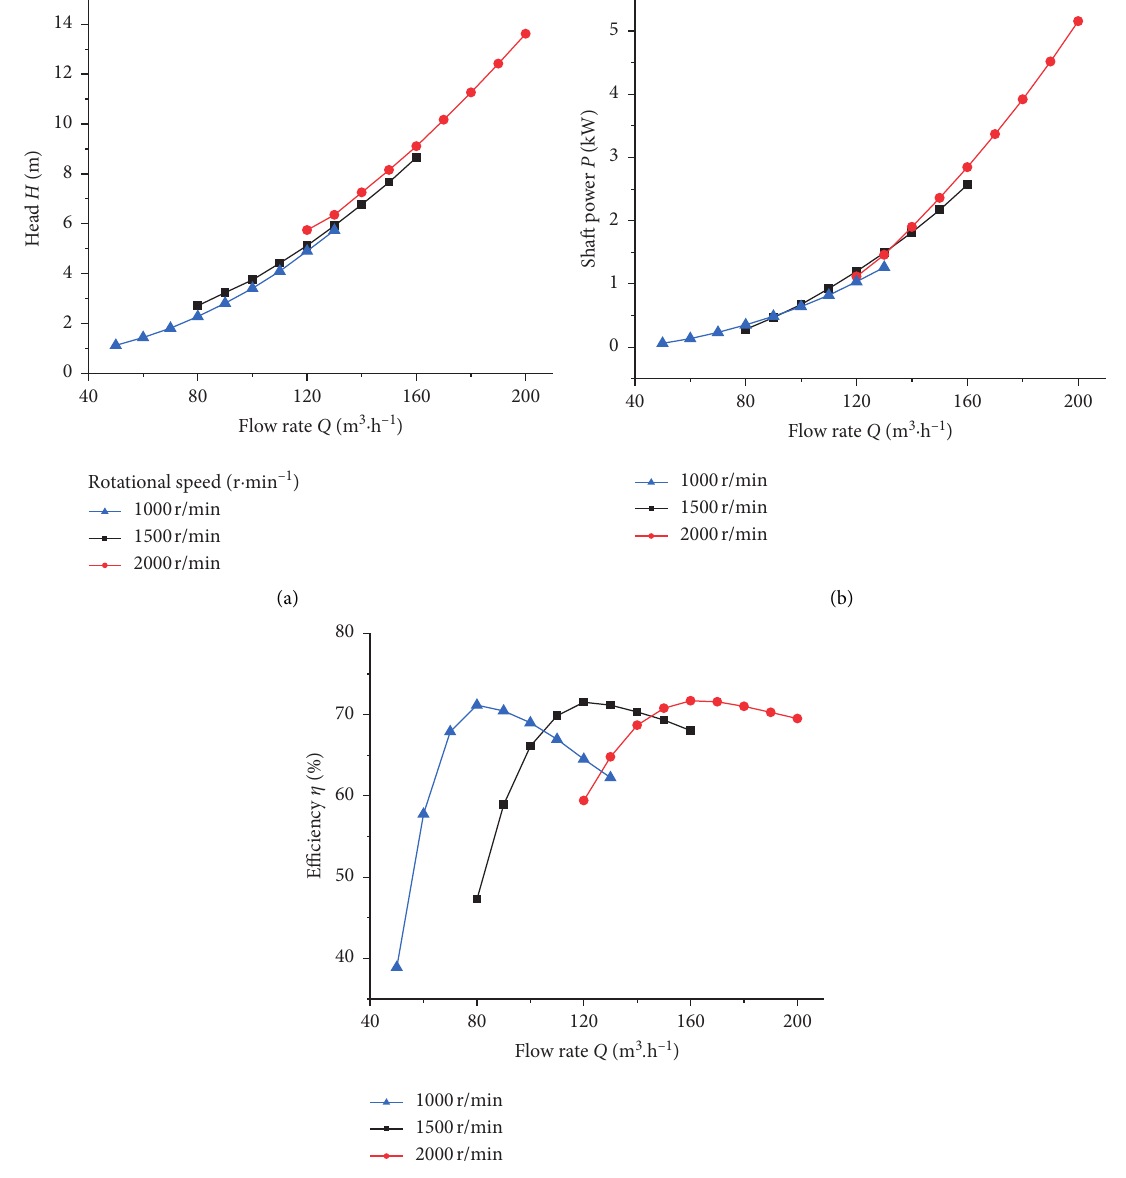
Figure 6: Performance curves of MF-PAT at different rotational speeds obtained by